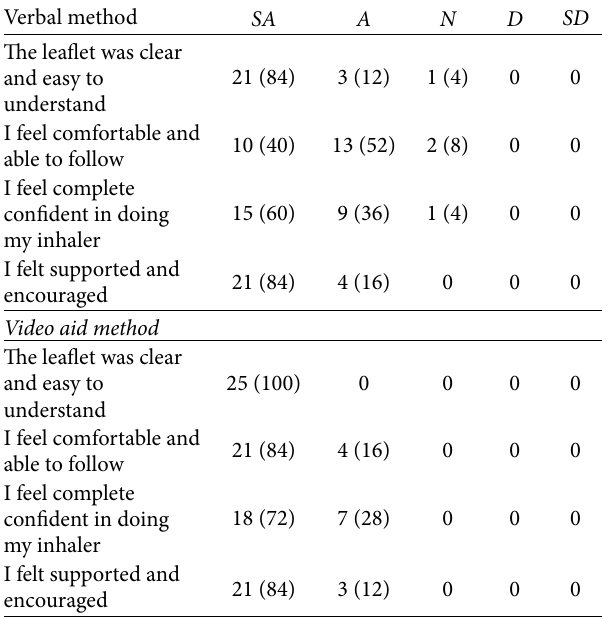
Table 10: Measurement of effectiveness of various types of demon-